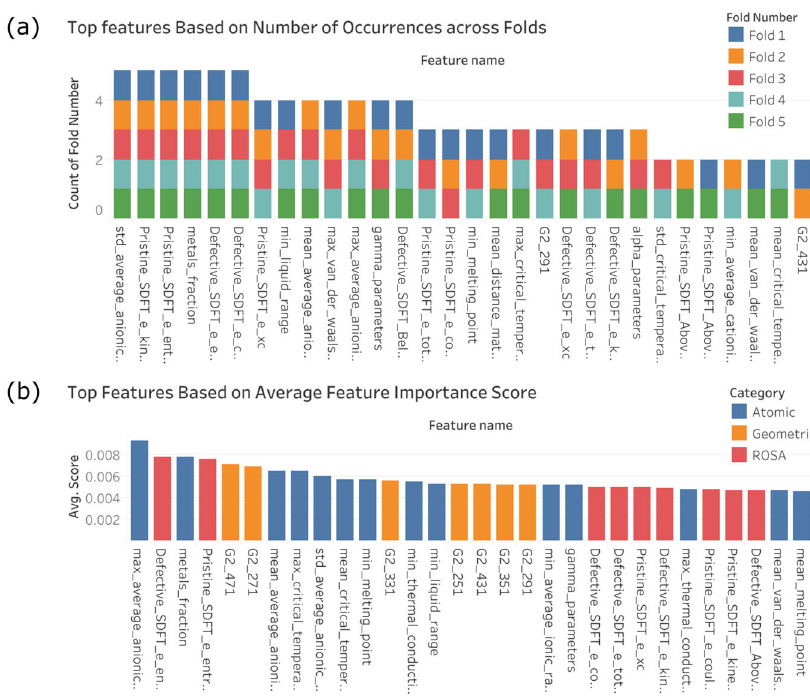
Fig. 3 Feature importance. a Top 30 features based on occurrence and b average feature importance score across fi